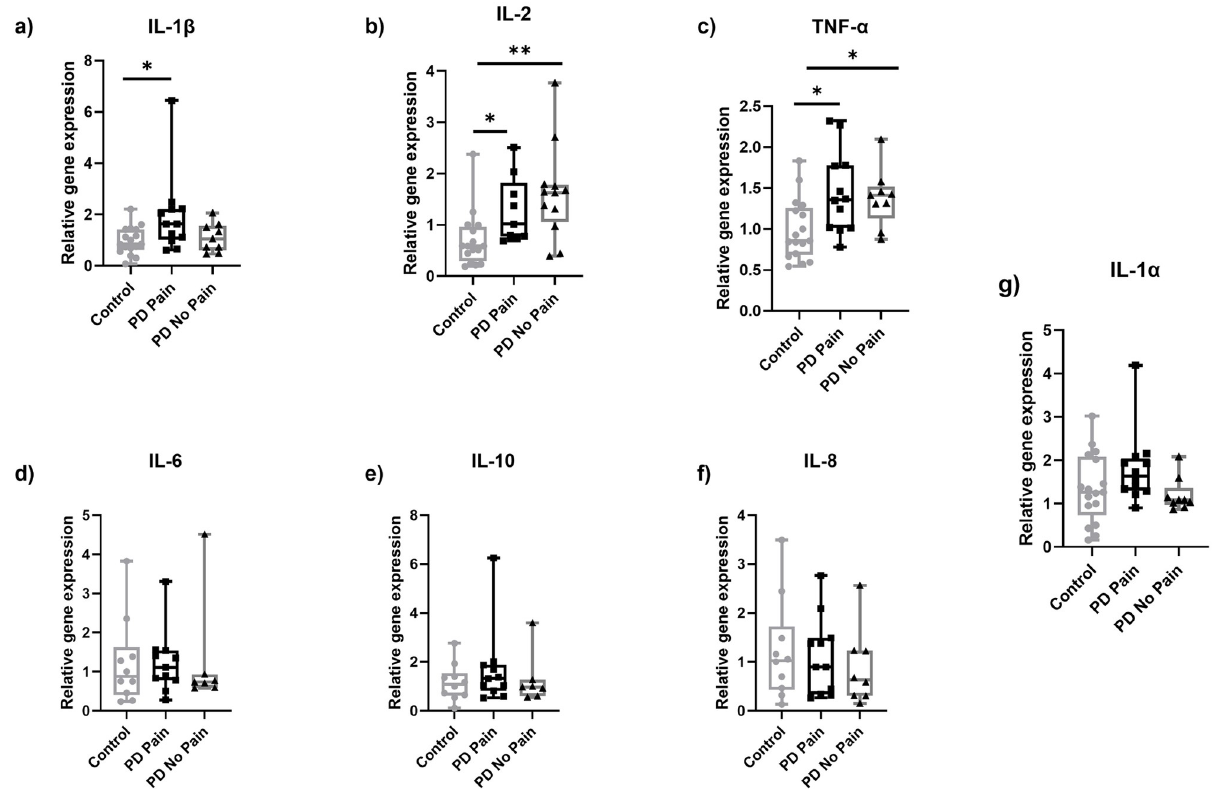
Fig 4. Gene expression of proinflammatory mediators in skin punch biopsy samples obtained from the lateral lower leg of PD Pain patients, PD No Pain patients, and healthy controls. IL-1 β gene expression was higher in skin samples of PD Pain patients compared to controls (a). IL-2 (b) and TNF- α (c) expression was higher in skin samples of PD Pain and PD No Pain patients compared to controls without intergroup difference. No intergroup differences were found for the investigated markers IL-6 (d), IL-10 (e), IL-8 (f), and IL-1 α (g). Data are expressed as median ± range. Abbreviations: IL = interleukin, PD = Parkinson’s disease, TNF- α = tumor necrosis factor alpha. � P < 0.05. Kruskal Wallis followed by Dunn’s multiple comparisons.